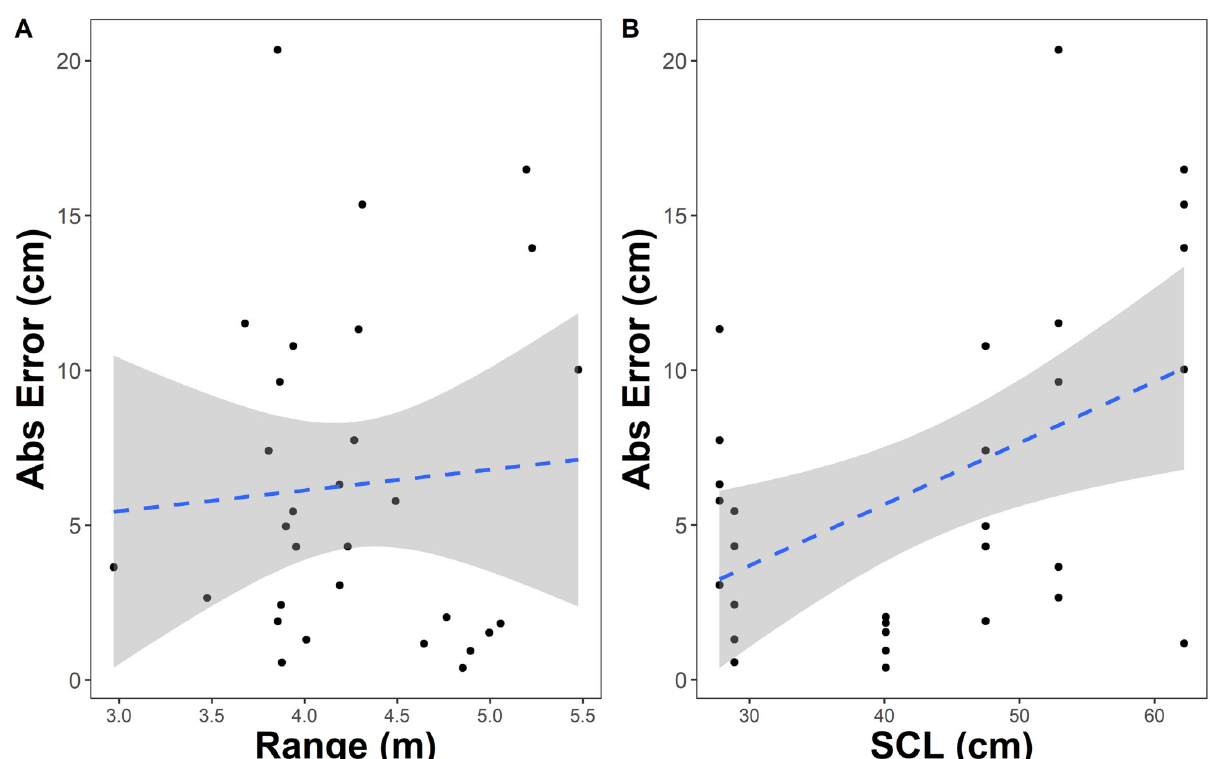
Fig 8. Relationship between absolute error and (A) range and (B) straight carapace length from the stereo-video camera system mounted to an unoccupied aerial vehicle. The dashed line and gray shaded area are the linear regression and standard error, respectively.